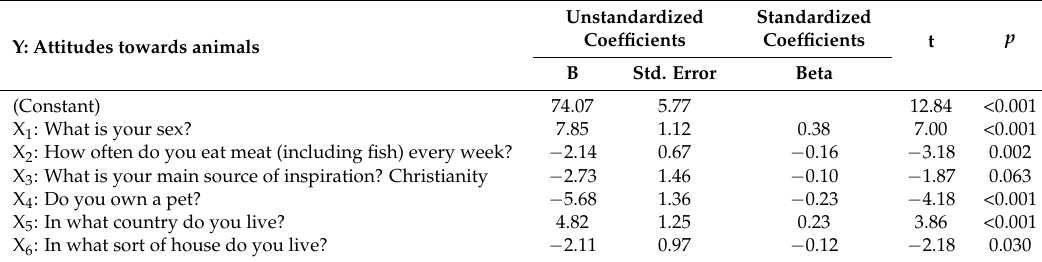
Table 4. Most prevalent correlations between independent questionnaire variables and the total AAS